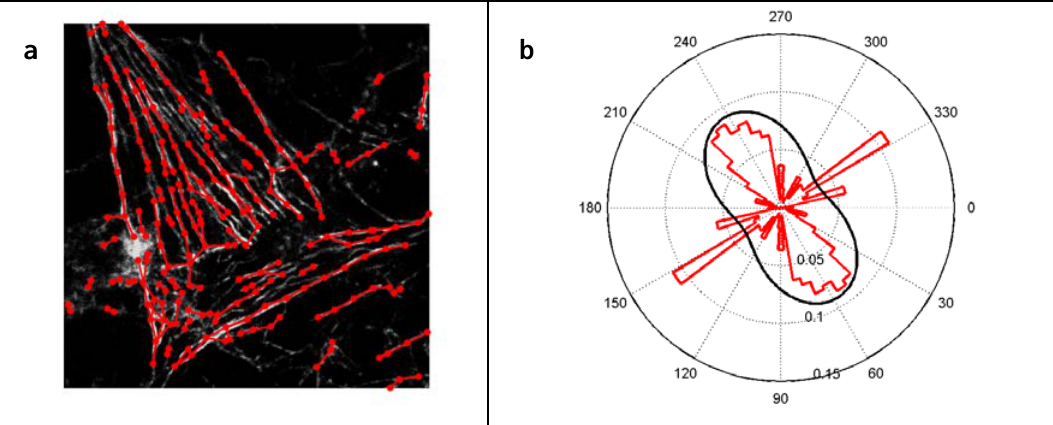
Figure 2. ( a ) Superposition of gray-scale image and automatically detected filaments (red). Circular markers illustrate branching points and bends. Lines connecting these markers indicate straight parts of the filament. ( b ) Polar plot of the length weighted histogram of angles of straight filament parts with the horizontal axis (red). The black line shows the fit of the von-Mises distribution on the half circle. Note that the contradiction to the assumption of one mode with the von-Mises distribution leads to a fit which is close to